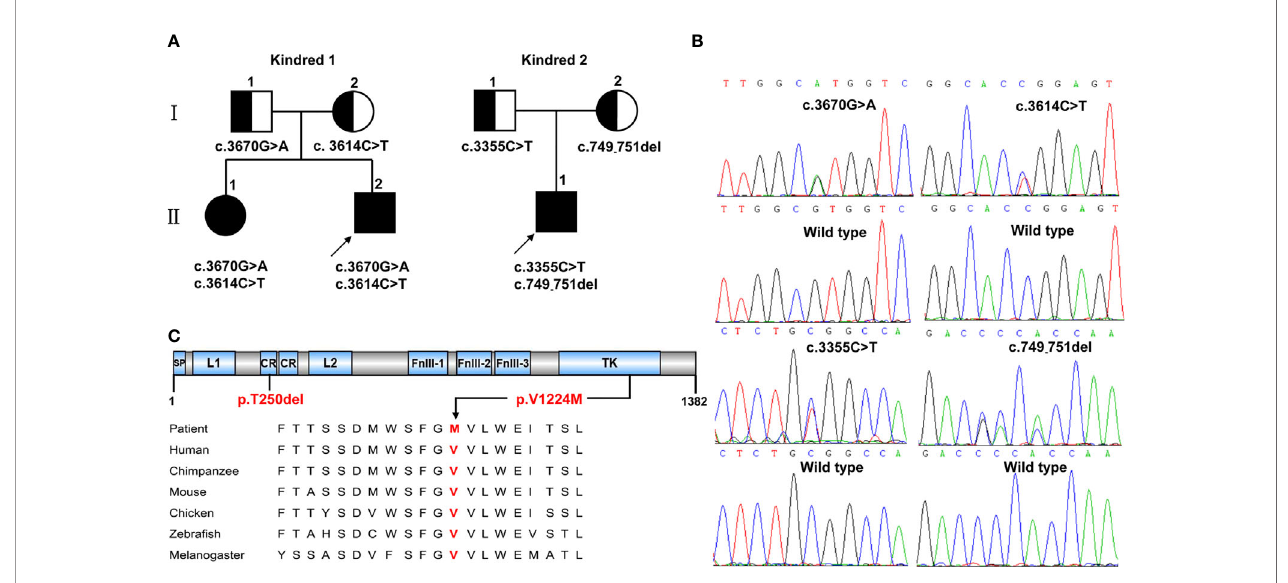
FIGURE 1 | INSR variants identi fi ed in two kindreds with severe insulin resistance syndrome. (A) The kindreds of patients with INSR -related insulin resistance syndrome and INSR variants. Kindred 1 with type A-IR; Kindred 2 with DS. (B) Sanger sequencing analysis showing the INSR gene variants. (C) The positions of the de novo variants p.Thr250del (p.T250del) and p.Val1224Met (p.V1224M) identi fi ed in patients 1,II.2 and 2,II.1 are shown below the INSR domains. The valine residue at position 1224 is highly conserved across different